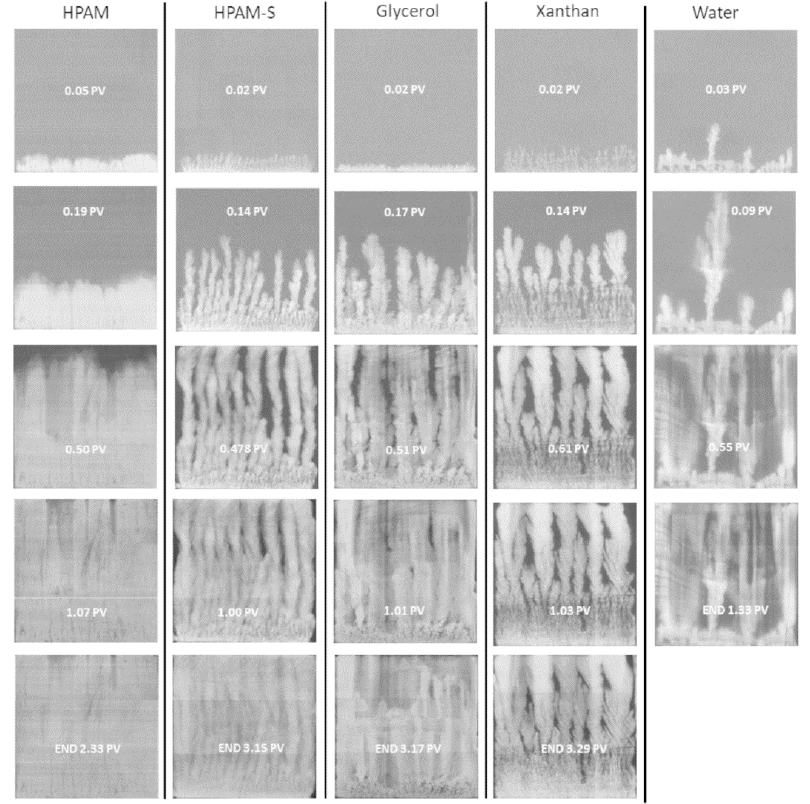
Figure 17. Two-dimensional (2D) X-ray images of oil displacement in sandstone slabs using HPAM, HPAM-S, glycerol, xanthan and water at rates varying between 0.3 and 0.8 mL/min, equaling a typical reservoir rate of 0.3 m/day. [107].